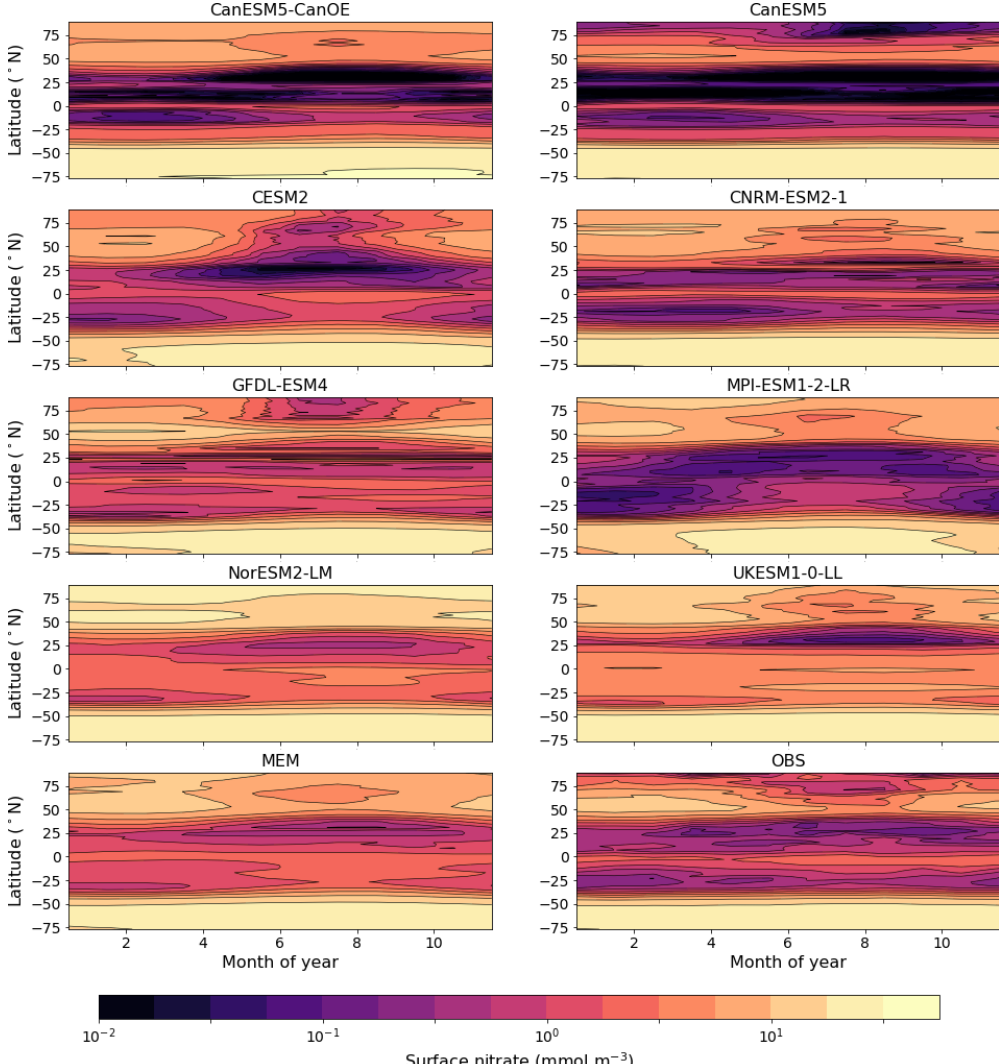
Figure 11. Climatological seasonal cycle of zonal mean surface nitrate concentration for a selection of CMIP6 models, a model ensemble mean (MEM) excluding CanESM5 and CanESM5-CanOE, and an observation-based data product (WOA2018). An alternate version showing only latitudes < 20 ◦ is given in Fig.